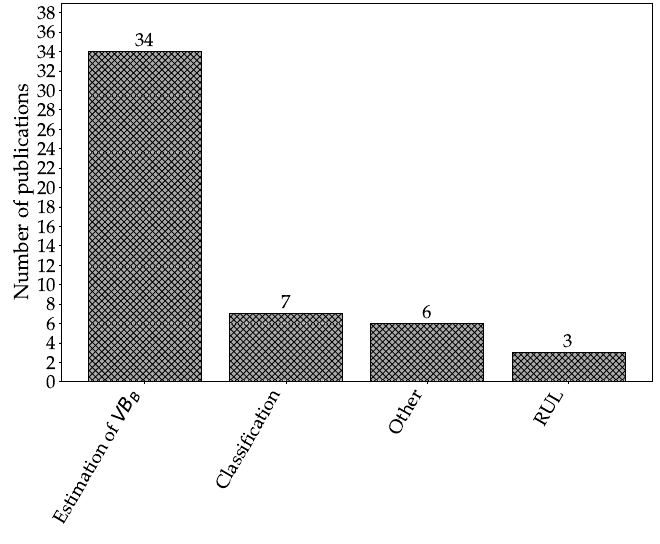
Figure 11. Repartition of outputs for ANN